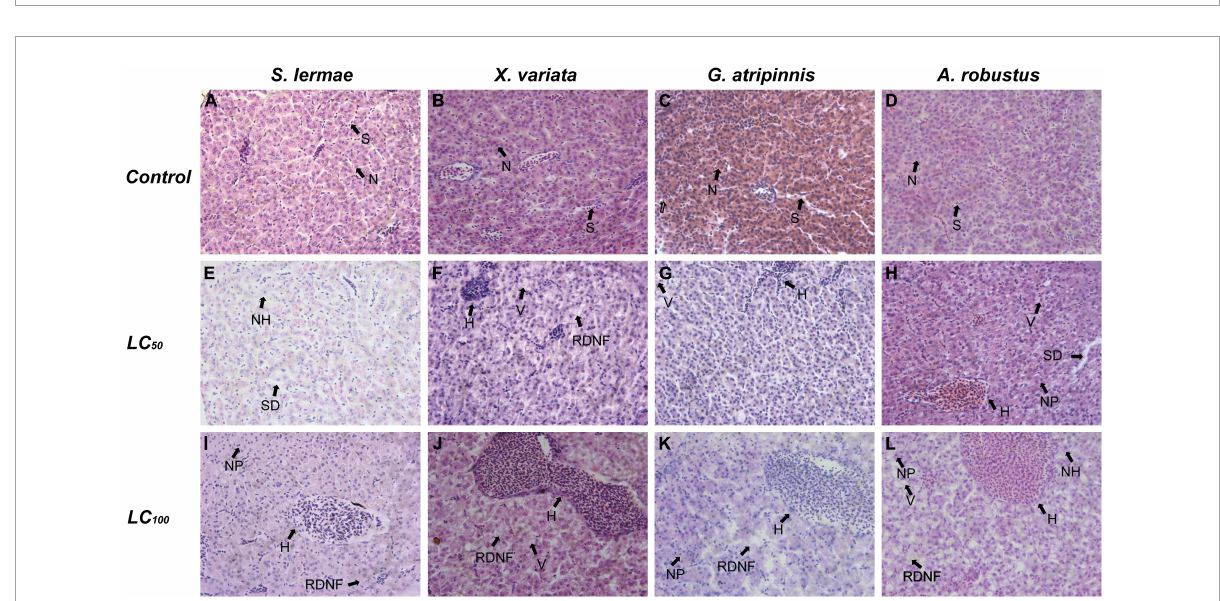
FIGURE4 Effect of acute exposure to NaNO 3 -N on liver histology of four goodeine species. Representative photomicrographs of liver sections stained with hematoxylin and eosin from control (A–D) , concentration closest to the LC 50 (E–H) and LC 100 (I–L) groups. H, Hyperemia; N, hepatocyte nucleus; NH, Nuclear hypertrophy; NP, nuclear pyknosis; RDNF, Relative decrease of nuclei frequency; S, sinusoid; SD, Blood sinusoid dilation; V, Vacuolation of the